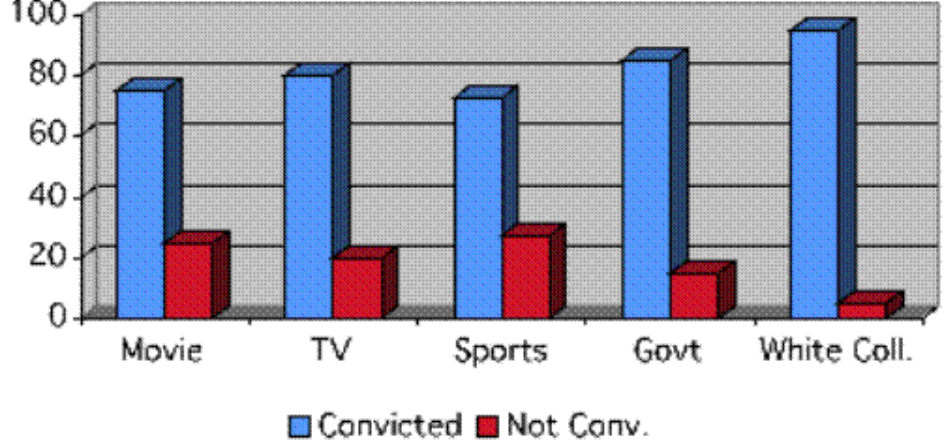
Figure 2: Percentage of Convictions by Notoriety,